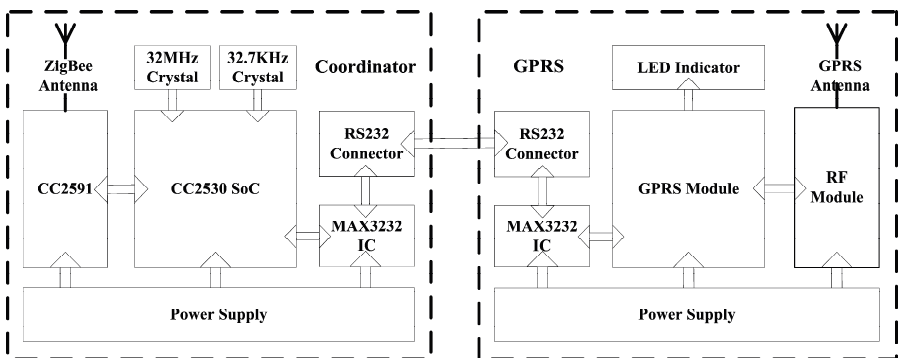
Figure 5. Block diagram of the network